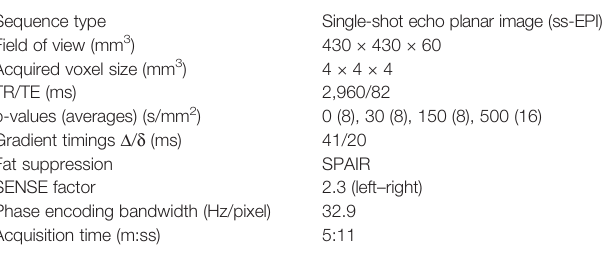
TABLE 2 | Acquisition parameters of the IVIM sequence. Sequence